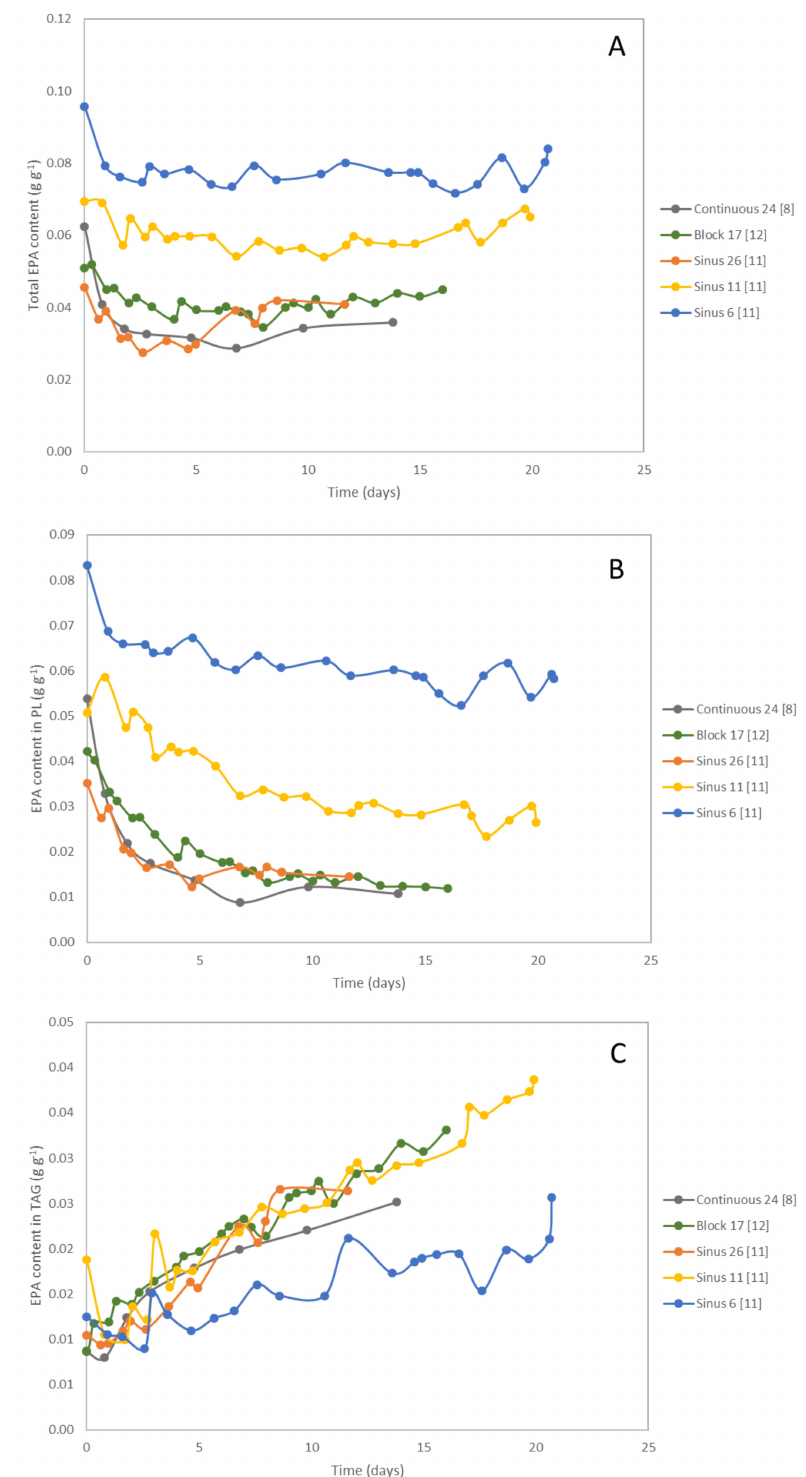
Figure A2. EPA content expressed per biomass (g EPA g dw − 1 ) in total lipids (TAG + PL) ( A ), in TAG ( B ) and in polar lipids (PL) ( C ) for the different biomass-specific photon supply rates and light regimes from the moment of nitrogen starvation